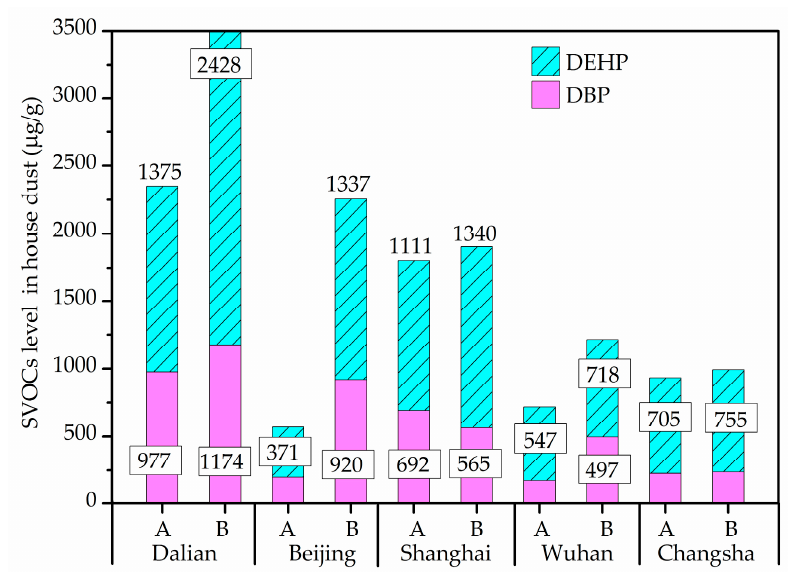
Figure 5. Semi ‐ volatile organic compounds (SVOCs) level in house dust in winter.